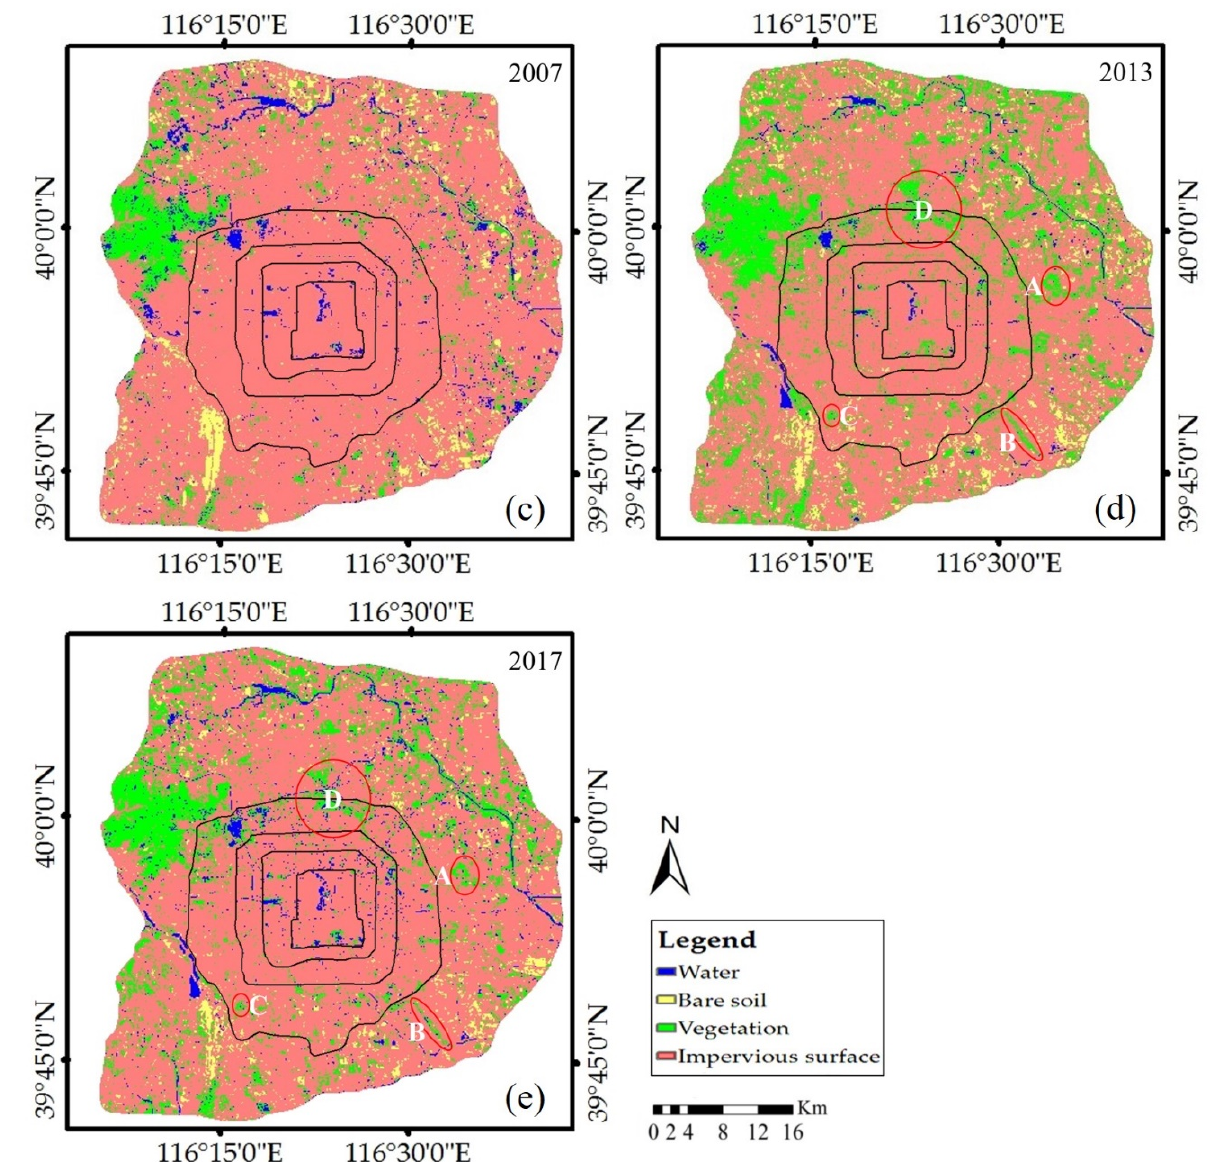
Figure 5. Land cover maps inside the sixth ring road of Beijing city in the years of ( a ) 1997; ( b ) 2002; ( c ) 2007; ( d ) 2013; ( e ) 2017. All maps are overlaid with the extent of the ring roads. Several typical patches of vegetation that appeared in 2013 and were generally kept constant in 2017 are marked in red